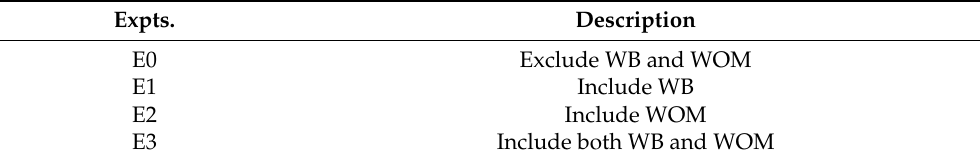
Include both WB and